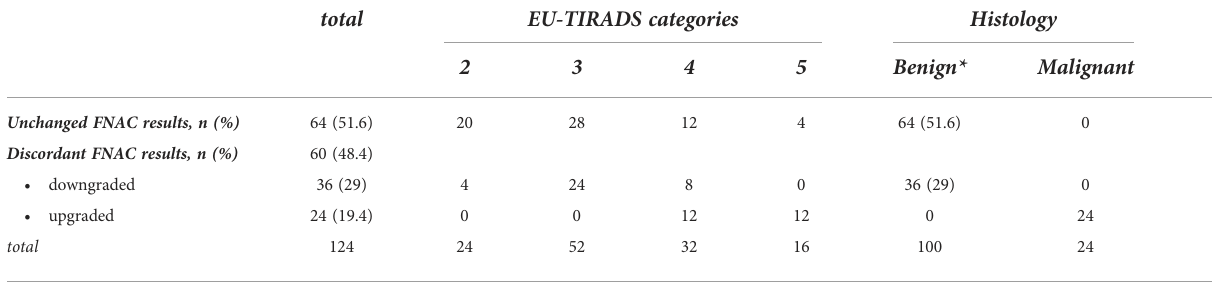
FNAC, fi ne-needle aspiration cytology; EU-TIRADS, European Thyroid Imaging and Reporting Data System. Unchanged FNAC result: same diagnoses between low-volume (LV) and high-volume (HV) centers. DowngradedFNACresults: “ better ” resultsobtainedintheHVvstheLVcenter(i.e.,TIR2vsTIR3A,TIR2vsTIR3B).UpgradedFNACresults: “ worst ” resultsobtainedintheHVvstheLV center (i.e., TIR3B vs TIR2, TIR3B vs TIR3A, TIR4 vs TIR3A, TIR5 vs TIR2). *Benignity was determined in 40 nodules at histology, while in 60 nodules at cytology plus US stability at the follow-up of not less than three years. Malignancy included 16 cases of classic papillary thyroid cancer (PTC) (four cases with a 20% of tall cells) and 8 follicular-variant